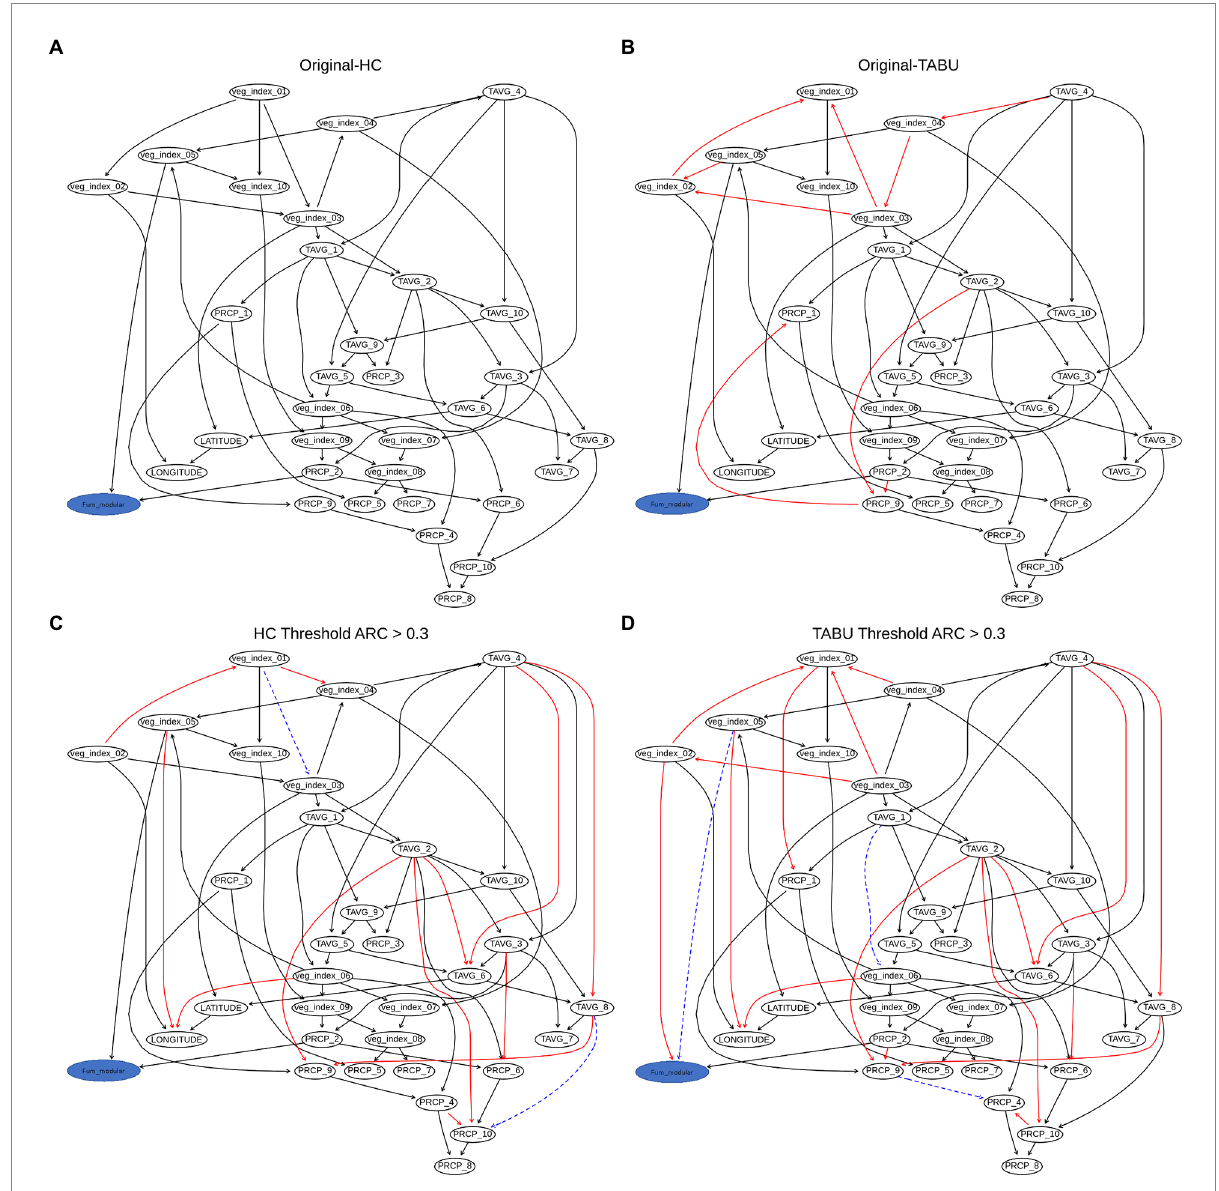
FIGURE 5 Weighted BN of FUM created by using (A) , hill-climbing (HC) and (B) , TABU algorithms. (C) Weighted network from HC evaluated using arc strength >0.3. (D) Weighted network from TABU evaluated using arc strength >0.3. The HC network was considered the baseline to which the other networks were compared, and the arrows are considered true positives, false positive arcs (which are missing or have different directions in the true network) are in red; false negative arcs are in blue and drawn using a dashed